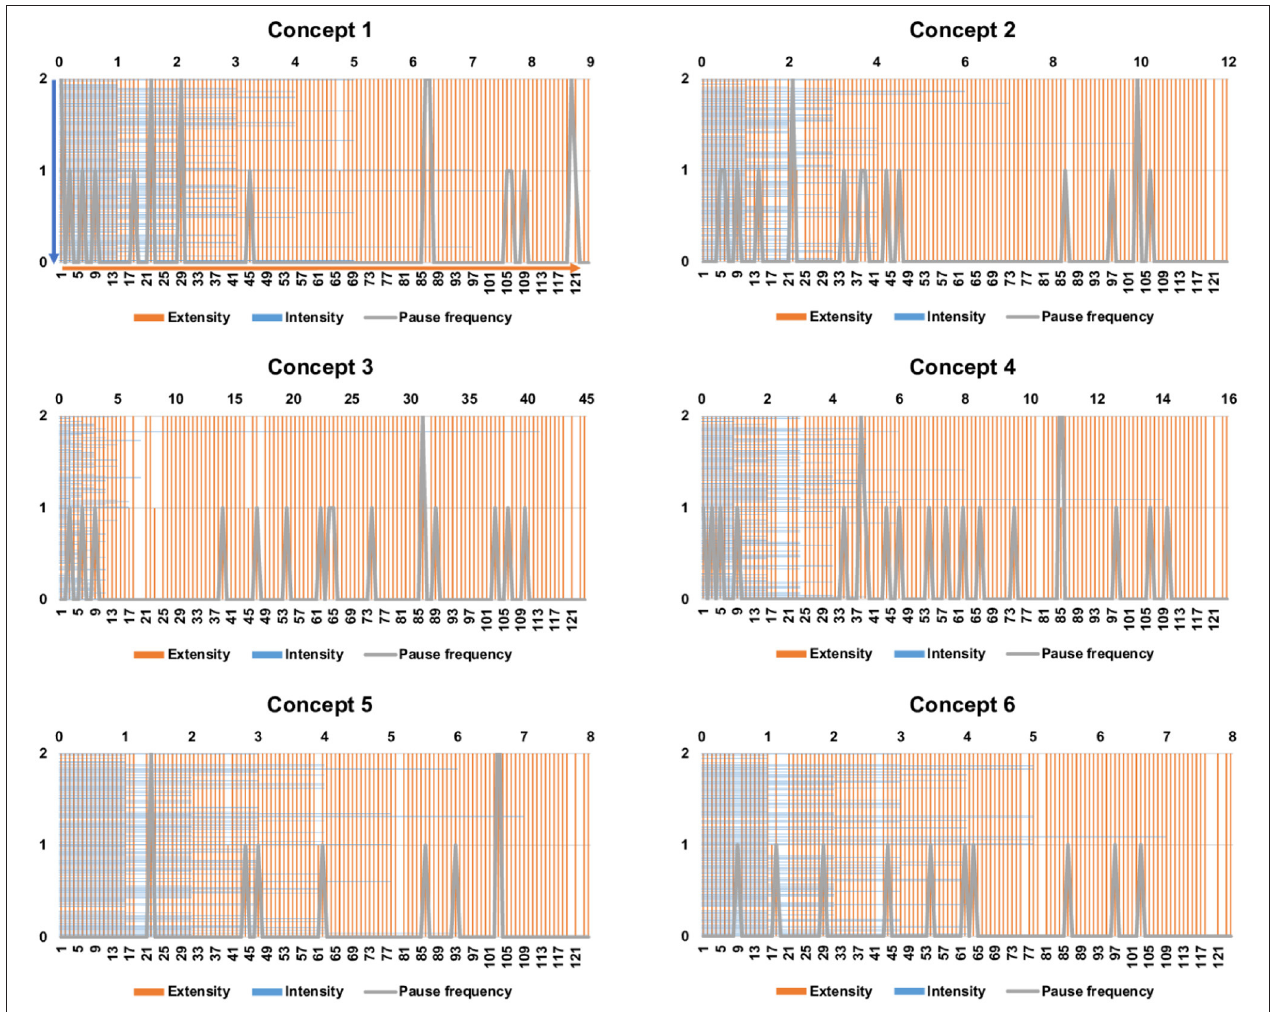
FIGURE 3 | Pre-class online video-viewing patterns (intensity, extensity, pause). (Upper X axis) Intensity (viewing times): Each blue line represents a case. Arrow shows the direction of cumulative cases. (Y axis, orange) Extensity (content completeness of video watching): 0, < 50%; 1, 50–90%; 2, more than 90%. (Y axis, gray) Pause frequency during online video learning in each case. (Lower X axis): case number for extensity and pause frequency. Arrow shows the direction of cumulative